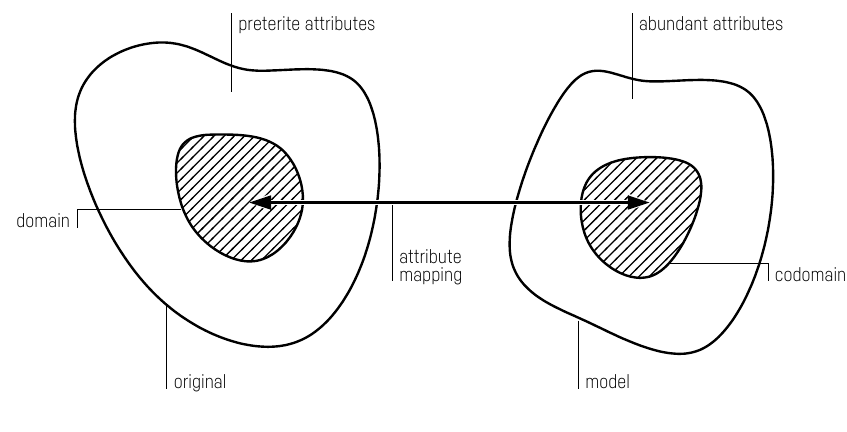
Fig. 1 Original–model